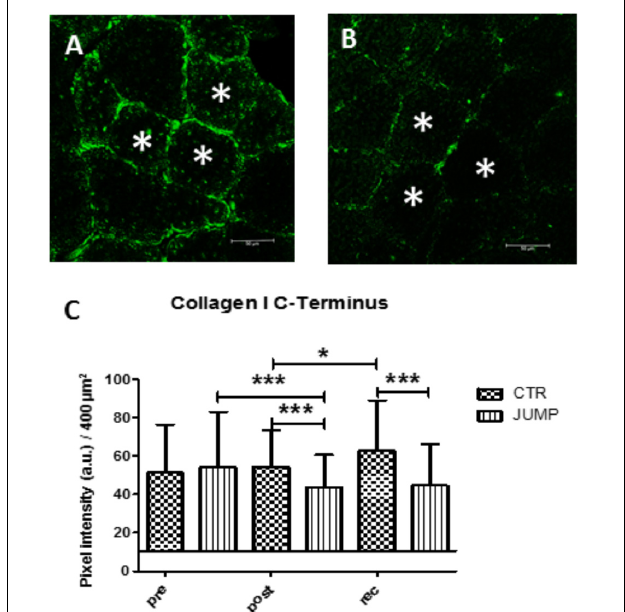
FIGURE 13 | Immunohistochemistry of collagen-1 network adaptation in RSL soleus biopsy. (A) , CTR group (post-BR HDT+59) shows increased collagen-1 immunoreactivity at peri- and endomysial tissue around cross-section myofibers, (B) , JUMP group (post-BR HDT+59) shows reduced collagen-1 immunoreactivity , (C) Quantification by area pixel-intensity determination (200 × 200 µ m 2 ) in each group at bed rest start (Pre), end (Post) and recovery (rec). ∗ p < 0.05, ∗∗∗ p < 0.001 ( n = 100 myofibers/cryosection). a.u., arbitrary units, Bar = 50 µ